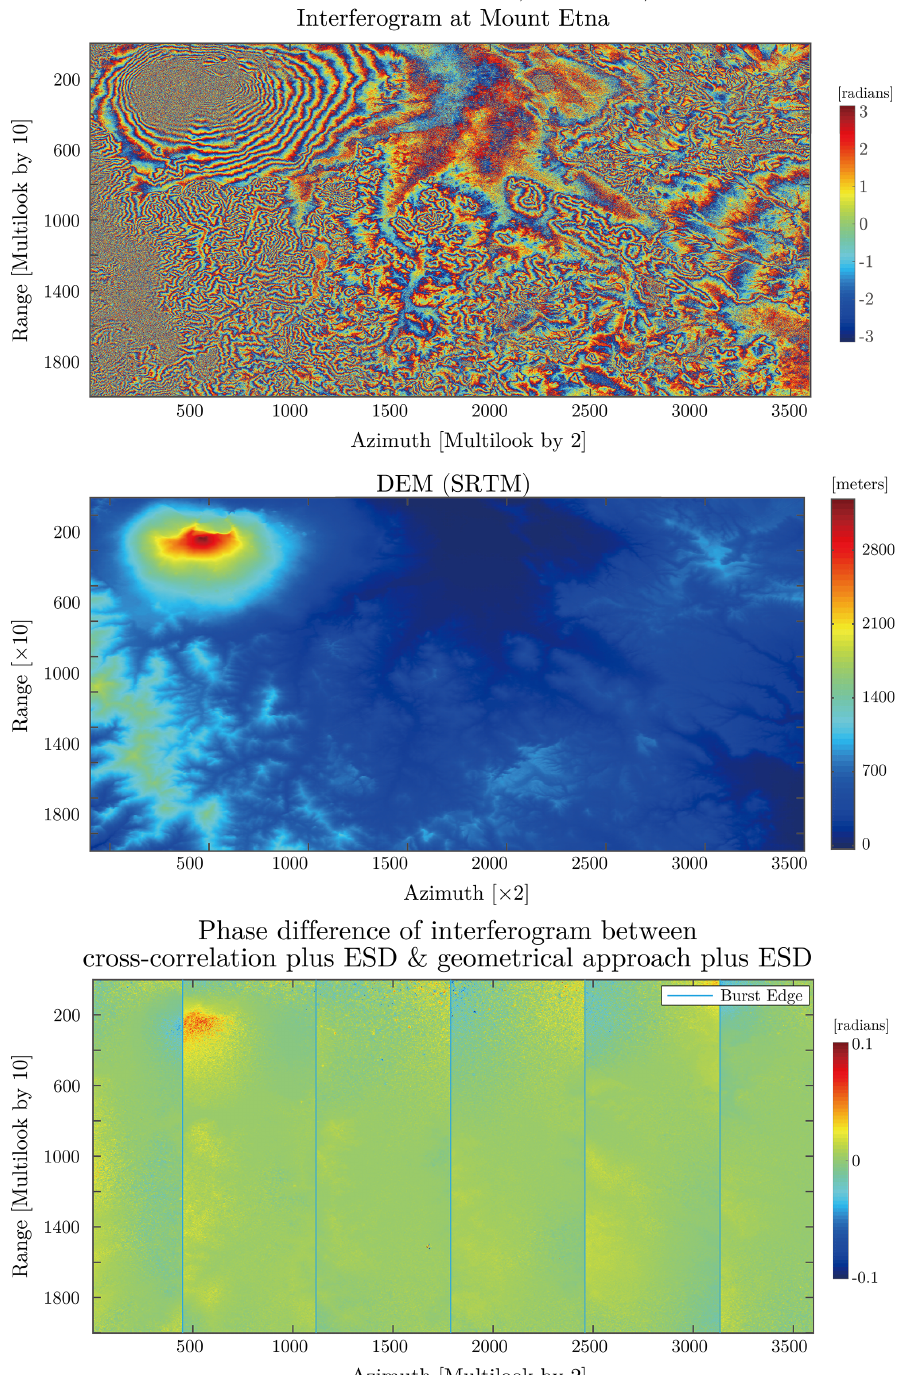
Figure 7. An example with Mt. Etna as the test site with 18 days temporal baseline and 123 m spatial baseline. ( Top ) the interferogram mutlilooked by 10 × 2 with no filter applied and no topographic phase removed; ( Middle ) the DEM using SRTM; and ( Bottom ) the difference of interferogram phase between the proposed approach and the established approach. It could be seen that the phase difference is the largest (close to 0.1 radians) at the top of the